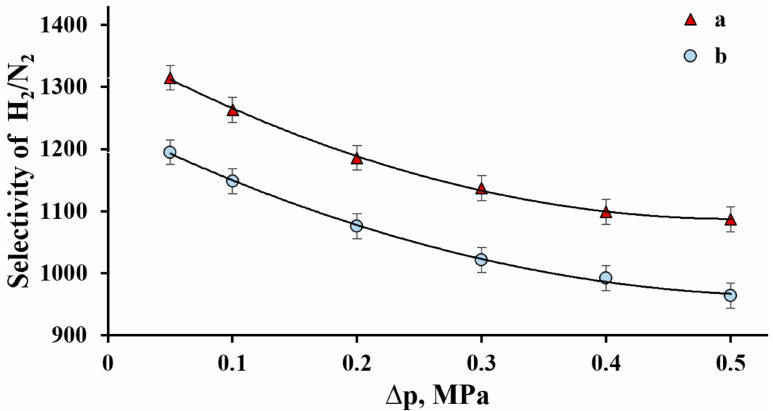
Figure 6. The gauge pressure dependence of the H 2 /N 2 selectivity at 300 ◦ C at the inlet side of PdCu–Nb–PdCu membrane modified with nanostructured coating (a) and non-modified membrane